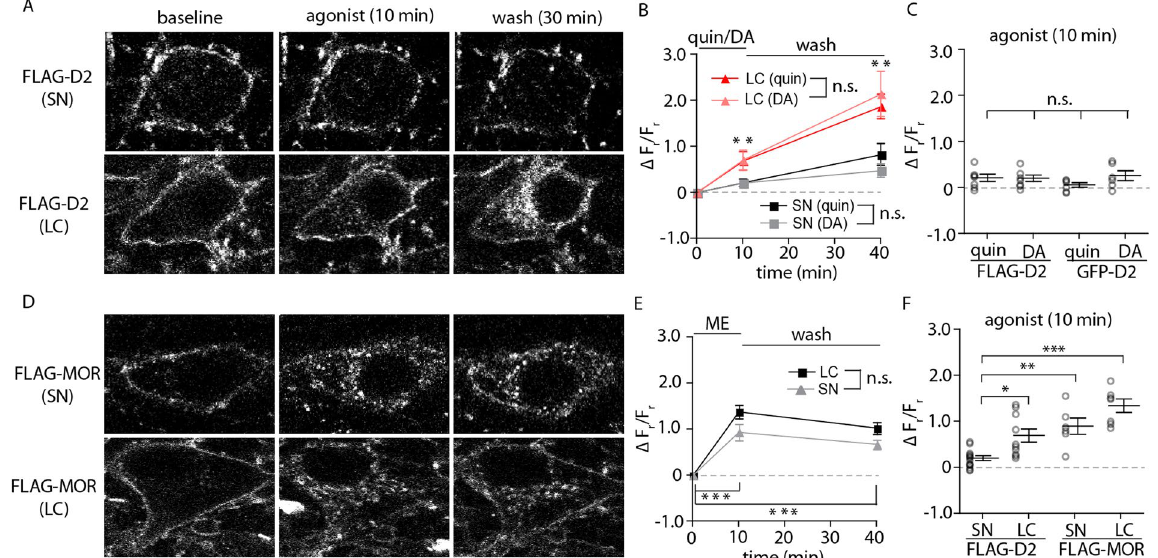
Figure 6. FLAG-tagged receptors reveal specificity of limited D2 receptor internalization. ( A ) Representative images of live neurons at baseline, following 10 minutes of agonist bath application (quinpirole 10 µ M, dopamine 100 µ M), and following 30 minutes of agonist-free wash. Slices were incubated in anti-FLAG M1- AF594 to label FLAG-tagged D2 receptors in the SN and LC prior to imaging. ( B ) FLAG D2 receptors in SN dopamine neurons show limited internalization following agonist exposure as measured by the change in the ratio of intracellular to membrane fluorescence ( Δ F r /F r ), only significant following the 30-min wash (not specified on graph). FLAG-D2 receptors in the LC show a significantly larger increase in the intracellular fluorescence relative to the membrane fluorescence ( Δ F r /F r ) when compared with FLAG-D2 receptors in SN neurons (n = 5–7, two-way ANOVA followed by Bonferroni). ( C ) The Δ F r /F r following 10 minutes of agonist exposure was not significantly different between GFP-D2 and FLAG-D2 receptors for either quinpirole or dopamine (n = 5–7, two-way ANOVA followed by Bonferroni). ( D ) Representative images of live neurons at baseline, following 10 minutes of agonist bath application ([Met] 5 enkephalin ME, 30 µ M), and following 30 minutes of agonist-free wash. Slices were incubated in anti-FLAG M1-AF594 to label FLAG-tagged µ -opioid receptors (MORs) in the SN and LC prior to imaging. ( F ) In both the SN and LC, FLAG-MORs show a sharp increase in Δ F r /F r following agonist exposure. There was a slight decrease in Δ F r /F r following the 30-minute wash period. ( F ) FLAG-D2 receptors in the LC and FLAG-MORs in both the SN and LC show significantly larger Δ F r /F r following agonist application than FLAG-D2 receptors in the SN (n = 6–14, two-way ANOVA followed by Bonferroni). n.s. denotes not significant, * p < 0.05, ** p < 0.01, *** p <